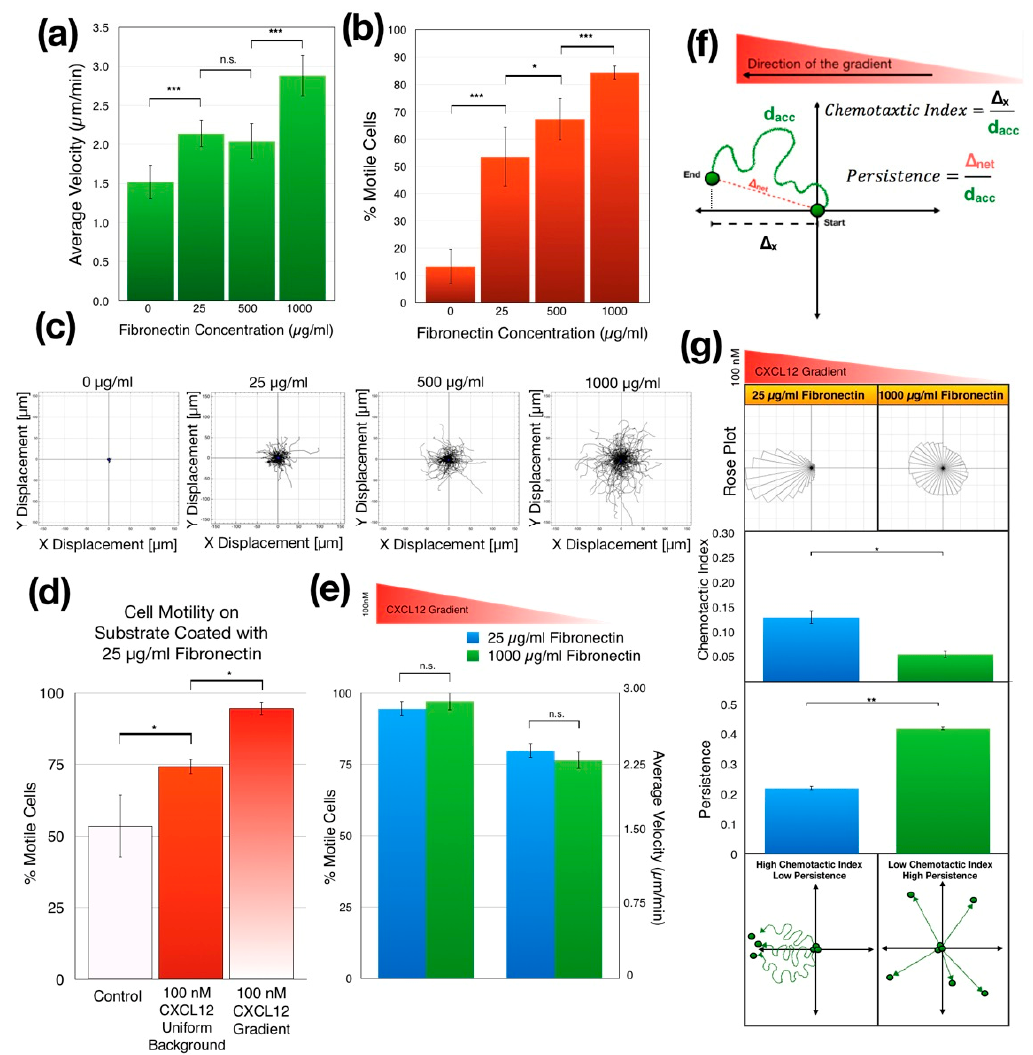
Figure 4. The effect of fibronectin concentration on Jurkat cell chemotaxis. ( a ) During random motion, the average speed of the migrating cells increased as the fibronectin concentration increased (p < 0.0001 by one-way ANOVA, **p < 0.01, ***p < 0.001 by post hoc two-tailed unpaired student's t -test with Bonferroni correction). ( b ) Also, during random motion, the percentage of motile cells increased as the fibronectin concentration increased (p < 0.0001 by one-way ANOVA, **p < 0.01, ***p < 0.001 by post hoc two-tailed unpaired student's t -test with Bonferroni correction). ( c ) Spider motility plots of randomly migrating Jurkat cells in microchambers coated with 0, 25, 500 and 1000 µg/mL of fibronectin, respectively. As the fibronectin concentration increased, cells spread more while maintaining their mass center at the origin (location of final mass center is shown as a blue dot). ( d ) Comparison of the percentage of motile cells in culture medium, in uniform 100-nM CXCL12 background and in 100-nM CXCL12 gradient in the microfluidic chambers coated with 25 µg/mL of fibronectin. (p < 0.0001 by one-way ANOVA, *p < 0.05 by post hoc two-tailed unpaired student's t -test with Bonferroni correction). (e) In CXCL12 gradients, the motility of the cells appears to